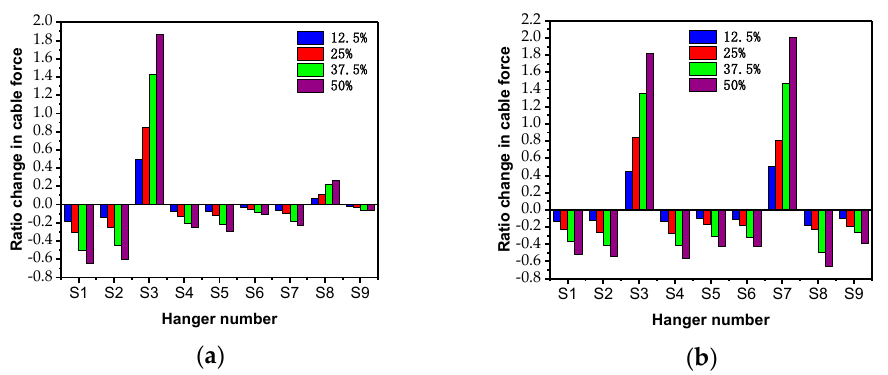
Figure 15. Model test identification results for considering creep and stiffness degradation: ( a ) the preset damage hanger is S3; ( b ) the preset damage hangers are S3and S7.